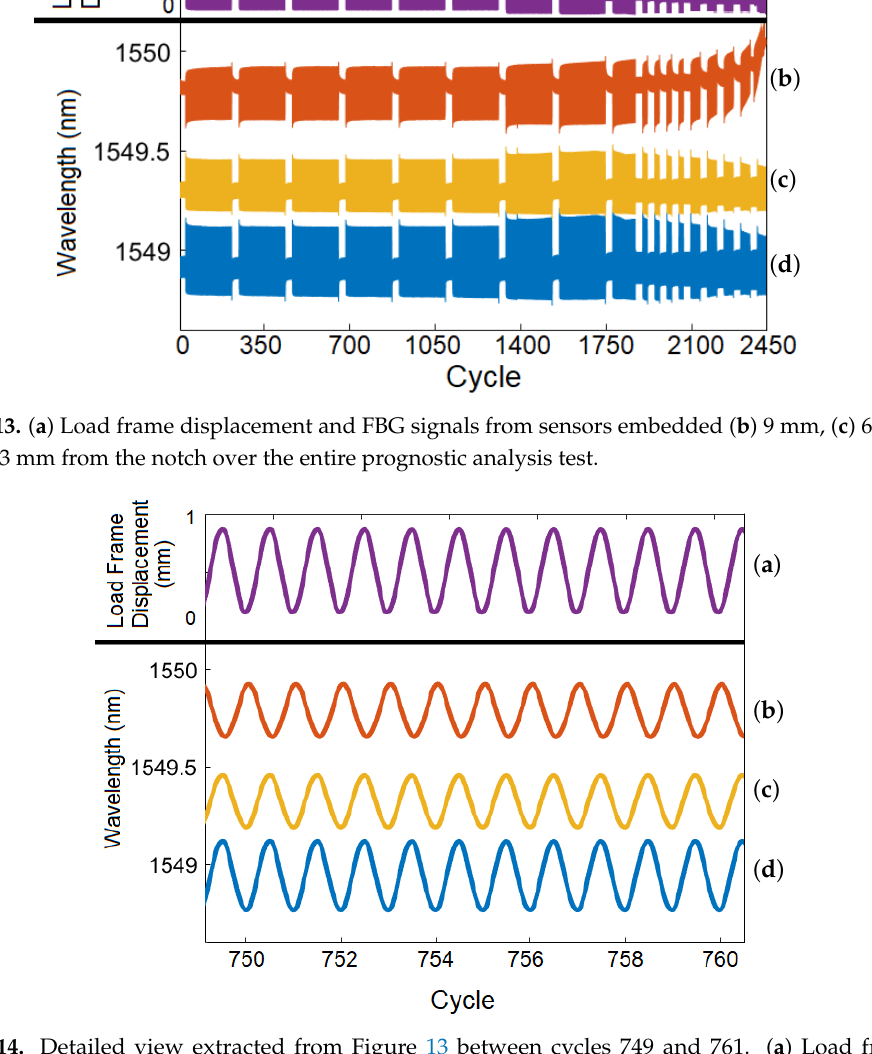
Figure 14. Detailed view extracted from Figure 13 between cycles 749 and 761. ( a ) Load frame displacement and FBG signals from sensors embedded ( b ) 9 mm, ( c ) 6 mm, and ( d ) 3 mm from the notch. Note the alternating crack-growth region (high wavelength amplitude) and low-amplitude region (low wavelength amplitude). The number of cycles of the crack-growth phase was reduced toward the end of the test to ensure that enough data was obtained as the crack grew. During the test, the crack initiated and grew in a single cycle to a length of 0.350 mm. Using the analysis technique described in Section 3.1.1, this increased crack length was detected by all three fibers in both the crack-growth phase and the low-amplitude phase. The following figures show the FBG signal as a solid line and the calculated upper bound of set means with no crack as a dotted line. The red circles indicate the mean of each set. When the red circle crosses above the dotted line, the FBG detects a crack. As illustrated by Figures 15–20, all embedded FBGs successfully detect the crack after the seventh high-amplitude set when the crack reaches a length of 0.350